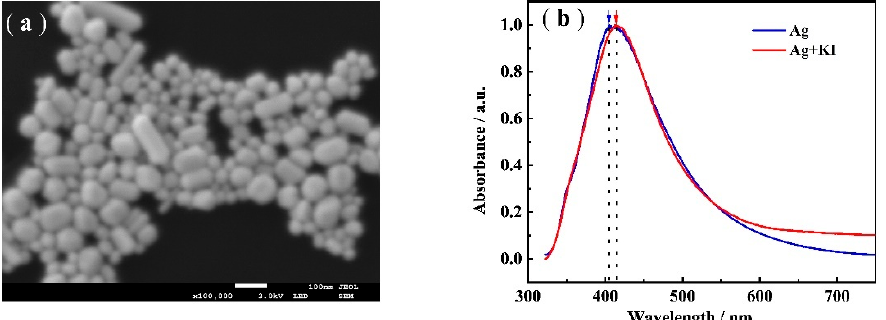
Figure 1. SEM images of: ( a ) Ag NPs; and ( b ) The UV-Vis spectra of Ag NPs (blue line) and Ag-I NPs (red line).